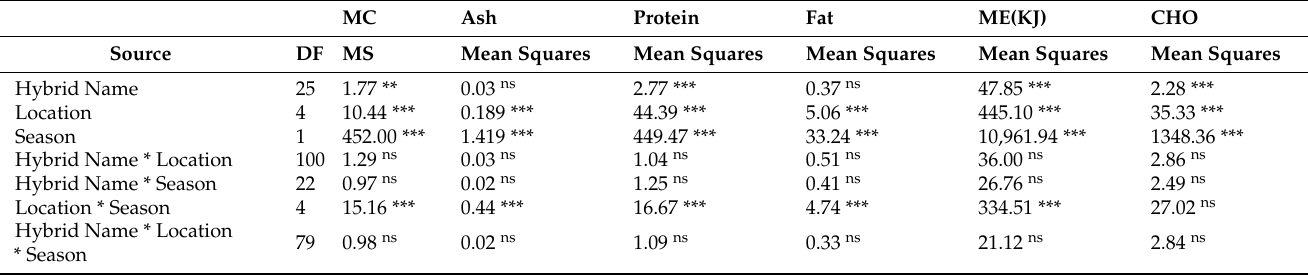
Table 2. Analysis of variance of proximate composition of the maize hybrids planted across five locations.